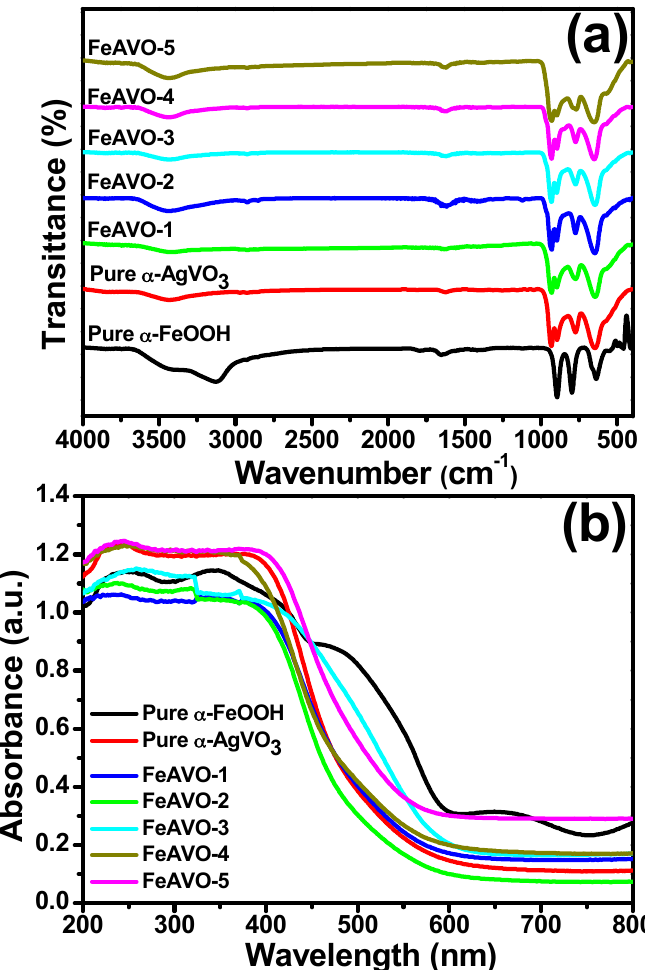
Figure 3. ( a ) Fourier-transform infrared (FT-IR) spectra of pure α -FeOOH, pure α -AgVO 3 and different α -FeOOH/ α -AgVO 3 nanocomposite photocatalysts and ( b ) UV-Visible diffuse reflectance spectra of pure α -FeOOH and pure α -AgVO 3 and optimized FeAVO-3 nanocomposite photocatalysts.